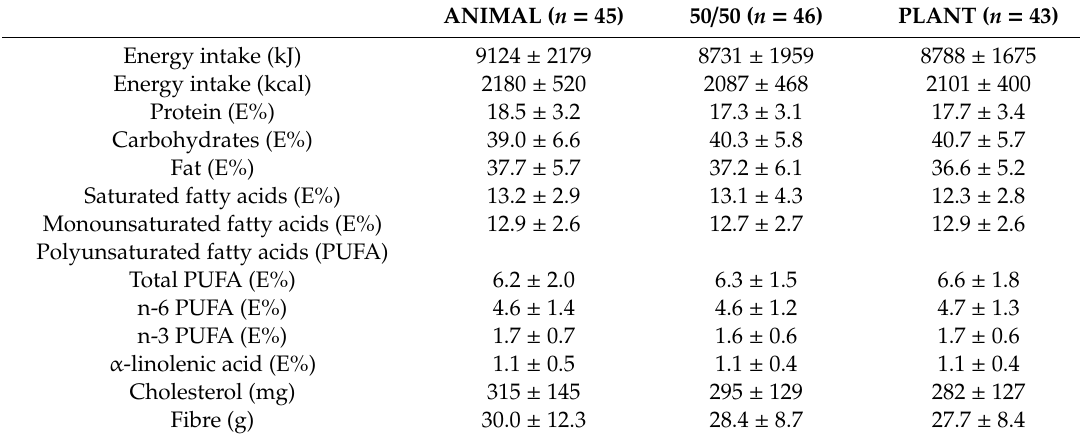
Table 3. Daily energy and nutrient intake in the intervention groups at the baseline; calculated as an average of 4-day food records. p values (ANOVA) between the groups > 0.05.